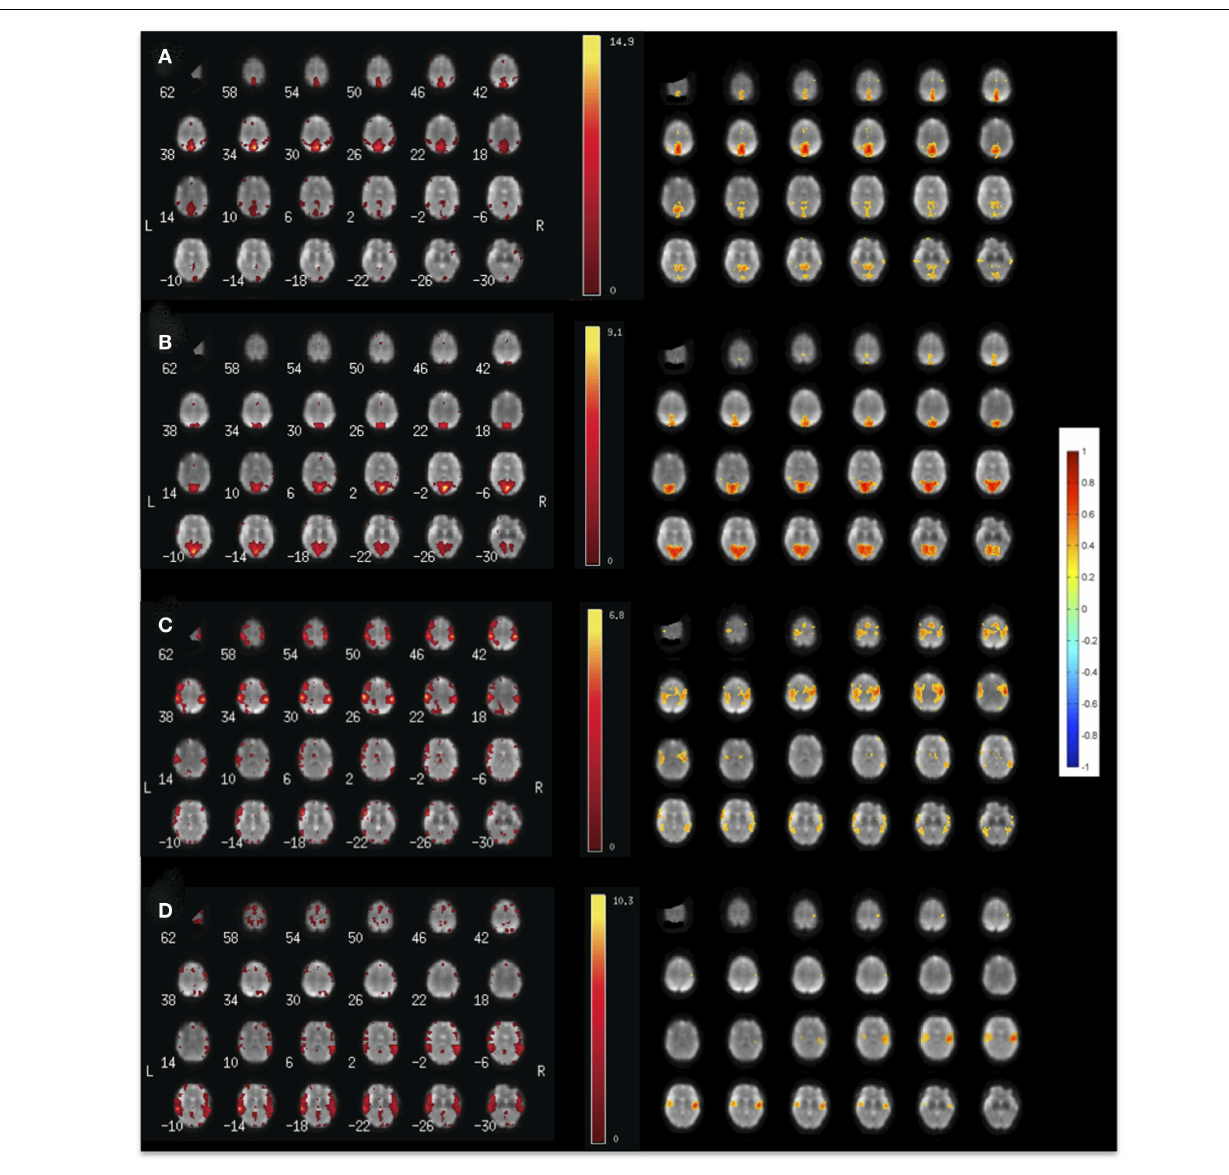
StealthStation neuronavigation system (Medtronics, MN, USA) for presurgical